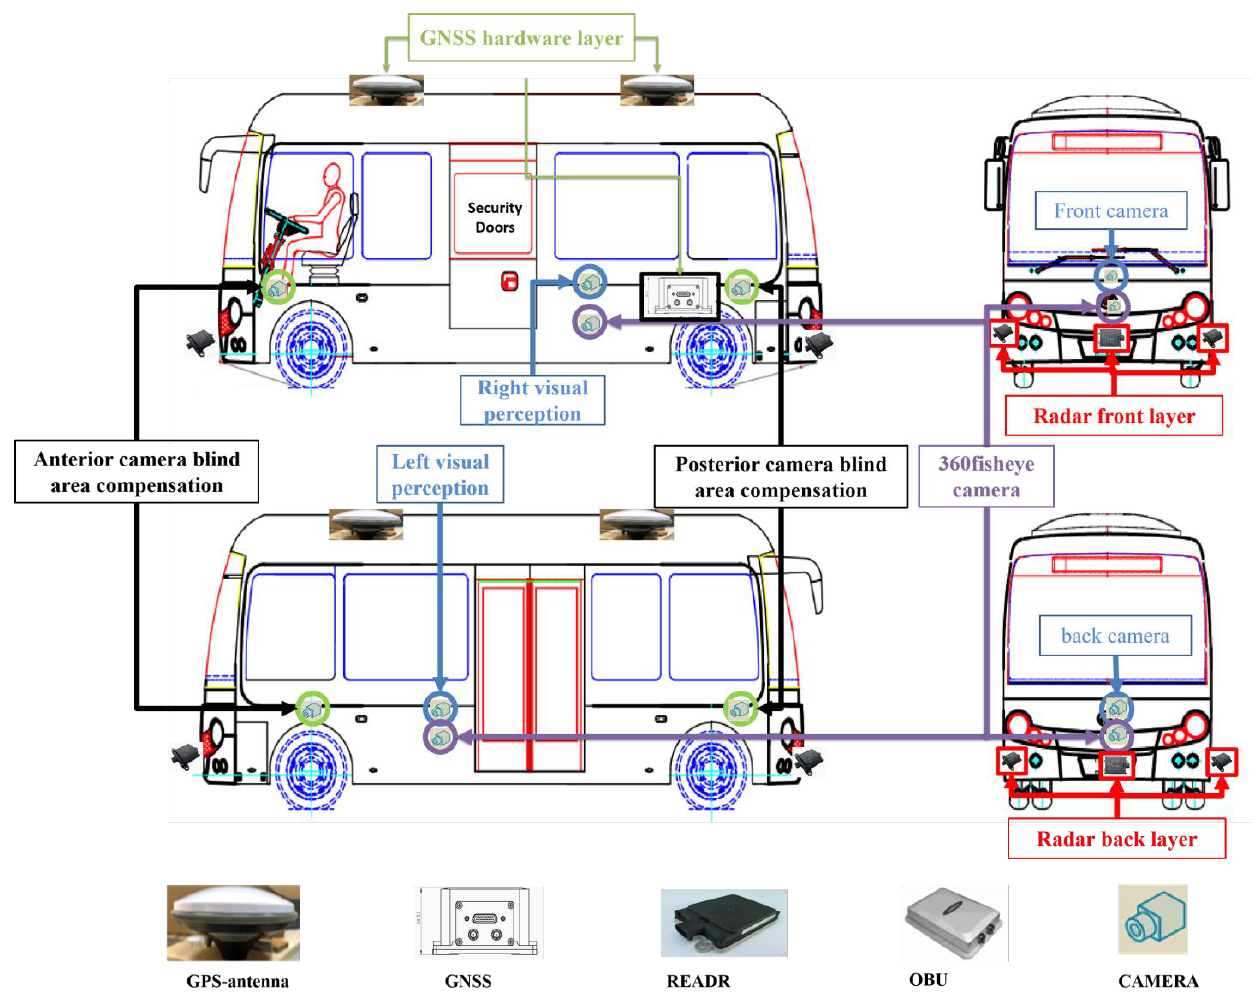
Figure 5. Location configuration of intelligent bus sensing system. (The green line indicates the installation of antenna and inertial navigation; the black line indicates the installation of front and rear narrow-angle camera; the blue line indicates the installation of middle narrow-angle camera; the purple indicates the installation of surround-view camera; and the red indicates the installation of front and rear millimeter wave radar.)